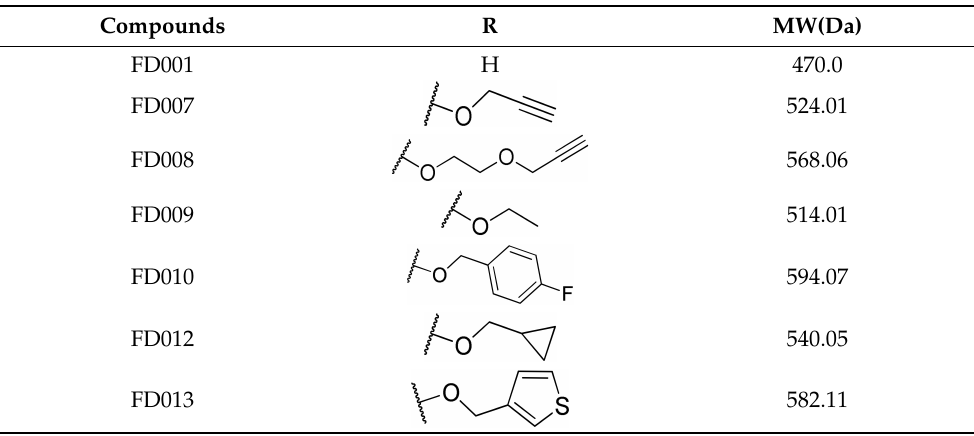
Table 1. Structure of FD001 and its